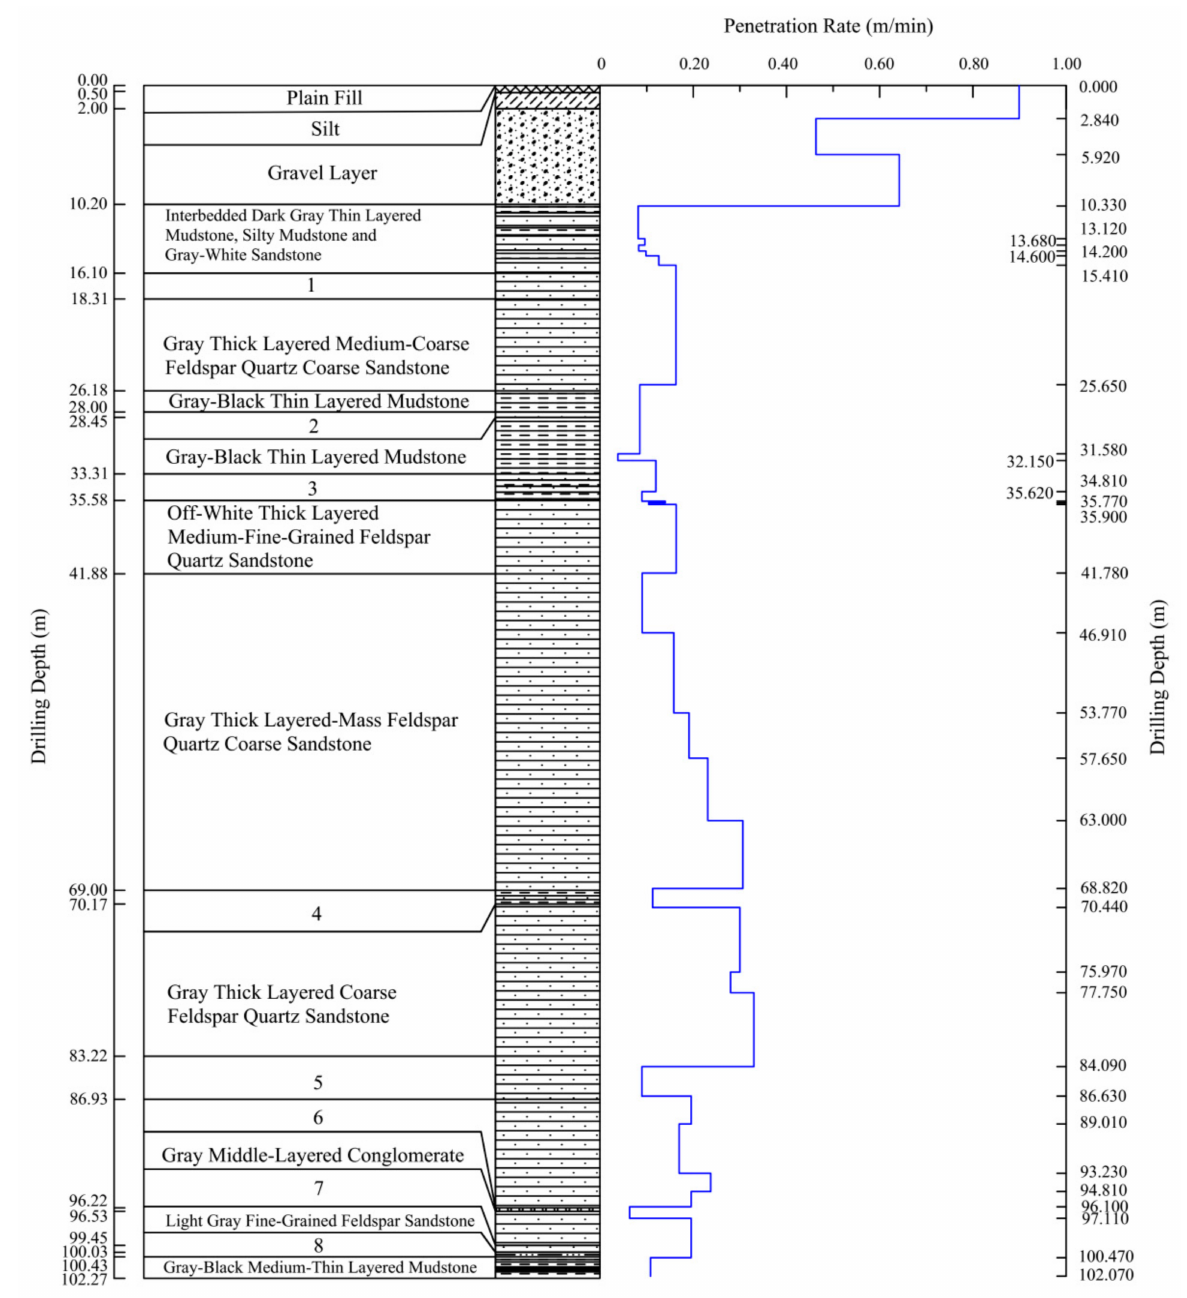
Figure 11. Contrast chart between manual cataloguing and DPM cataloguing of the borehole in Yan’an city. The numbers 1–8 refer to lithologies obtained by manual cataloguing. 1: Moderately thick layers of off-white fine-grained feldspar sandstone, 2: moderately thick layers of light grey fine-grained feldspar sandstone, 3: interbedded grey–white sandstone and grey–black mudstone, 4: grey–black mudstone with grey–white fine sandstone, 5: thick layers of off-white medium- to coarse-grained sandstone, 6: thick layers of grey coarse-grained feldspar/quartz sandstone, 7: thick layers of grey coarse feldspar/quartz sandstone, 8: dark grey argillaceous siltstone with fine sandstone